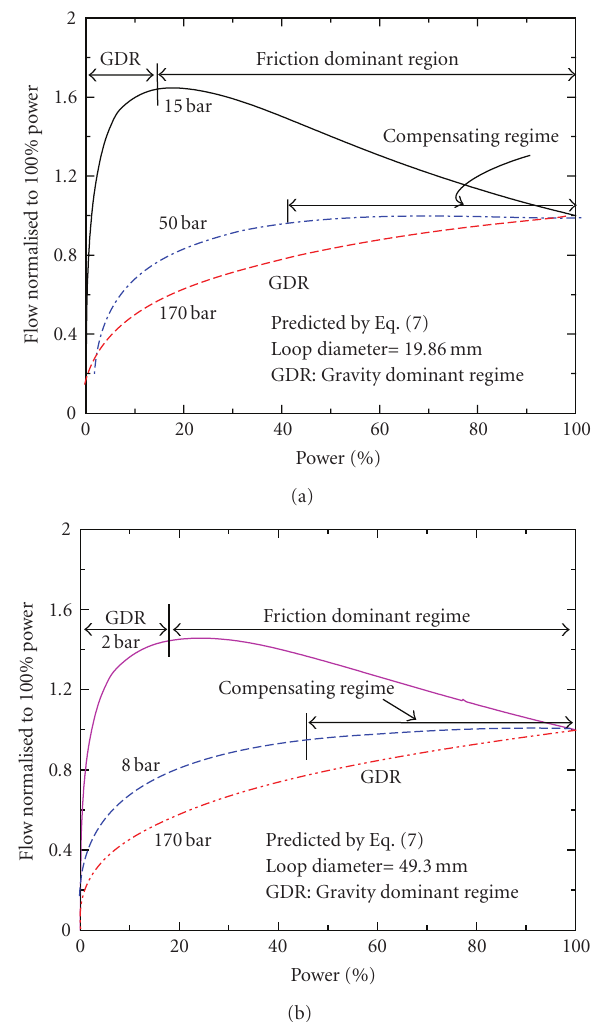
Figure 13: E ff ect of pressure on flow regime.